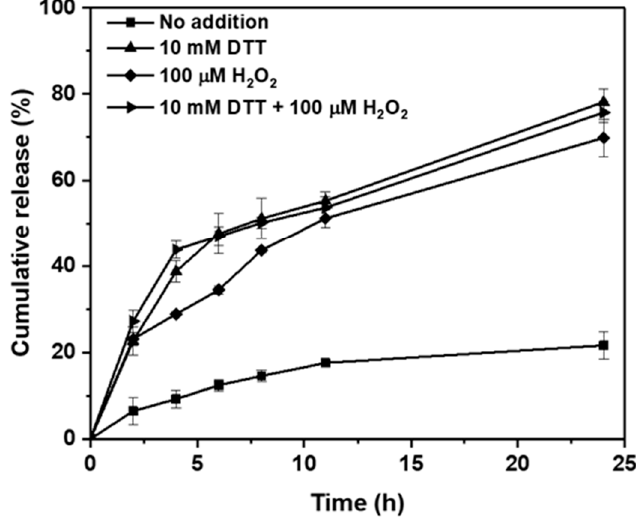
Figure 4. DTT- and H 2 O 2 -triggered DOX release from gemini mPEG-Cys-PMT micelles. Data are presented as mean ± SD of three independent experiments.